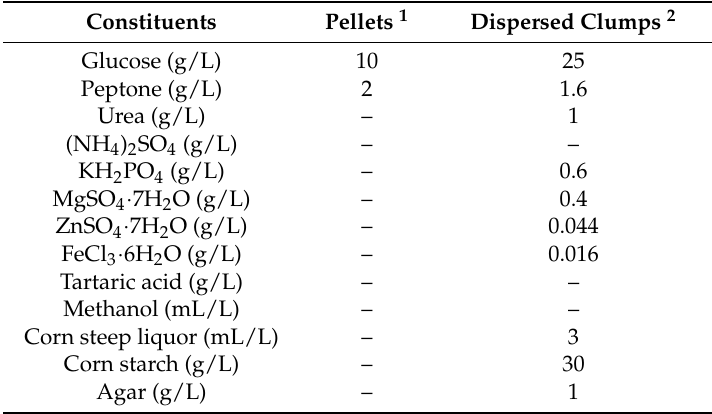
Table 1. Composition of different pre-culture media controlling the fungal